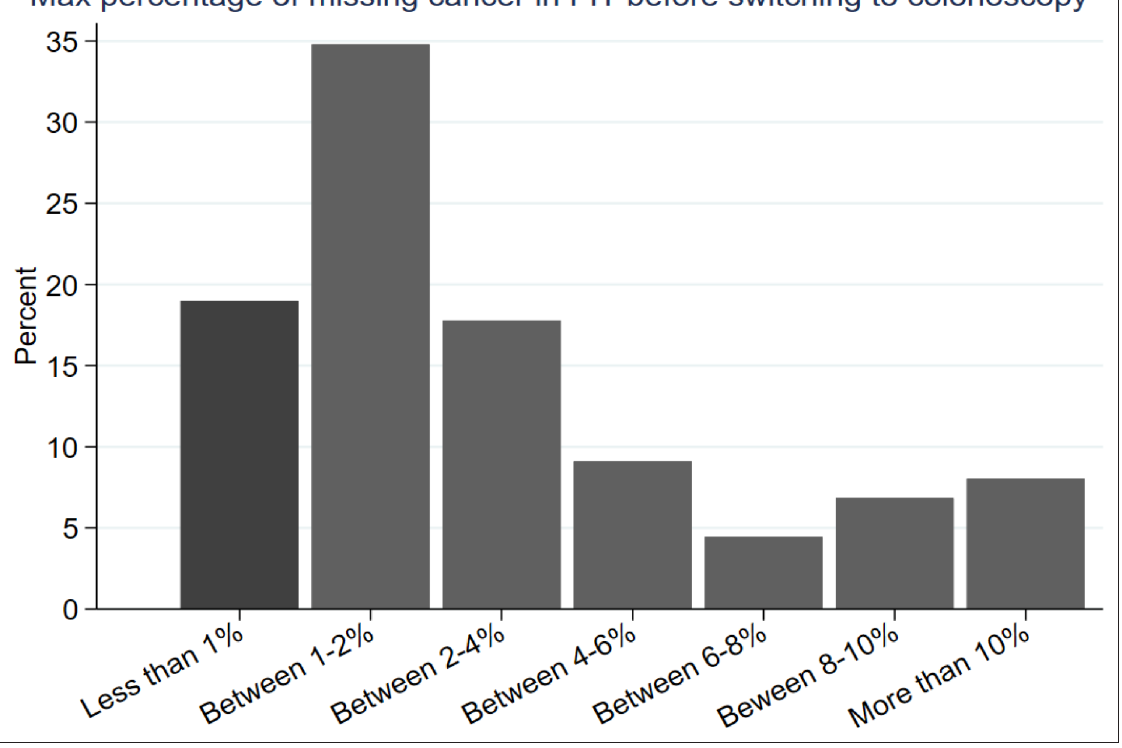
Figure 3 Switching point for responders’ faecal immunochemical test (FIT) preference over colonoscopy (CC) ( n = 1057). Those who preferred FIT over CC in choice one were asked to choose between a CC that misses 1% of colorectal cancers (CRCs) and an alternative FIT that misses 2% of CRCs in choice 2. Participants who kept choosing FIT over CC were presented with new scenarios in which the number of CRCs missed by FIT increased constantly by 2%. In the final scenario, FIT was reported to miss 10% of CRCs. The method let the authors infer the maximum acceptable number of CRCs missed by